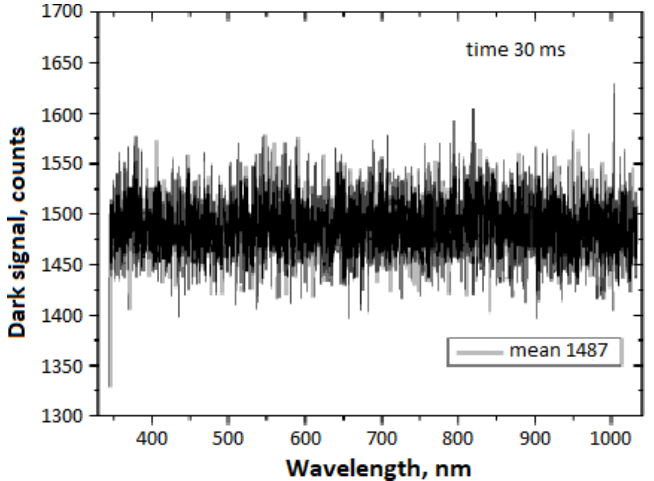
Figure A1. Dark signal of the spectrometer Ocean Optics USB4000-VIS-NIR-ES.